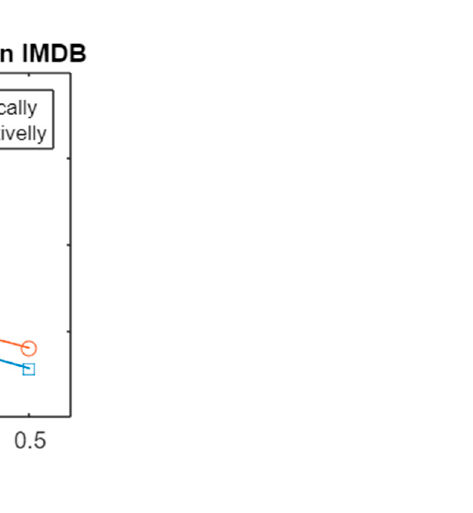
Figure 3. Accuracies for pruning an FC layer in the alternative architecture heuristically vs. pruning exhaustively.